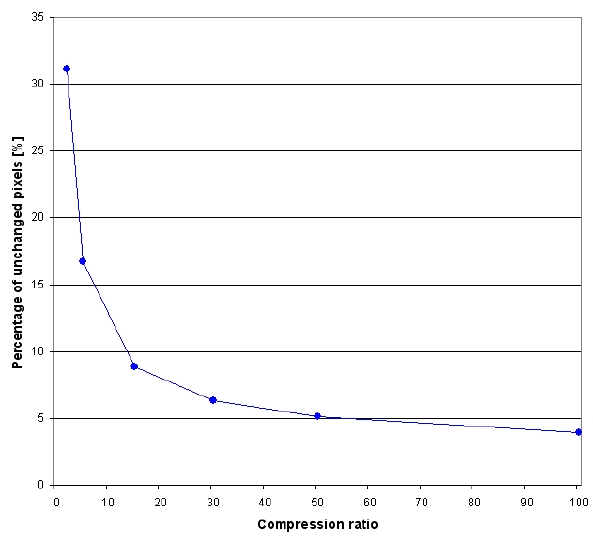
Figure 3. Percentage of unchanged pixels